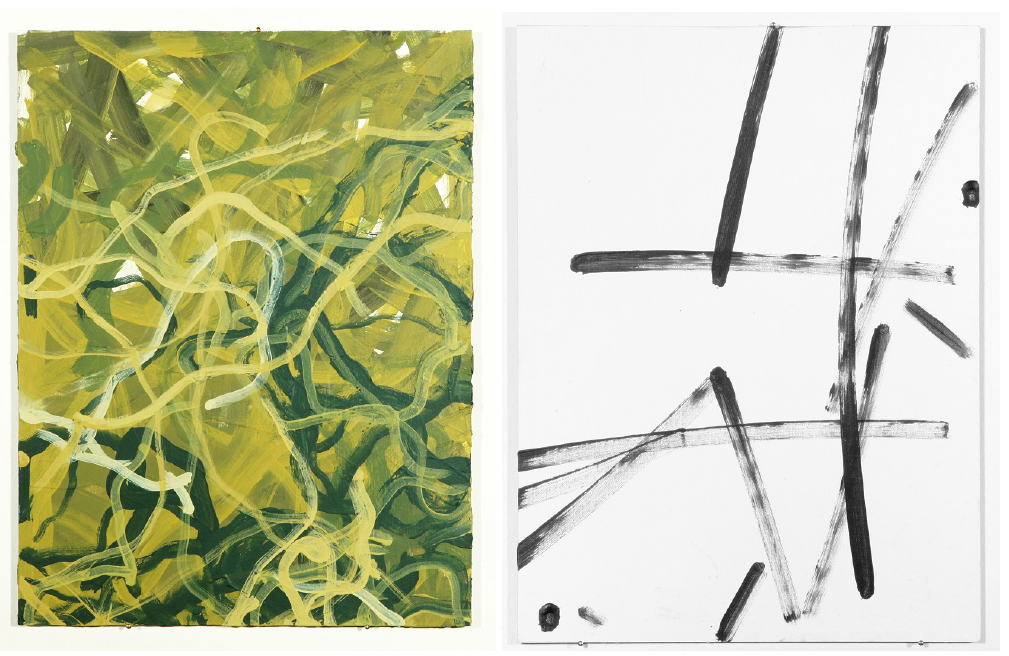
Figure A1. “Just Before it Snaps”, Acrylic on canvas, 30 cm × 40 cm. 2016, c (cid:13) Liat